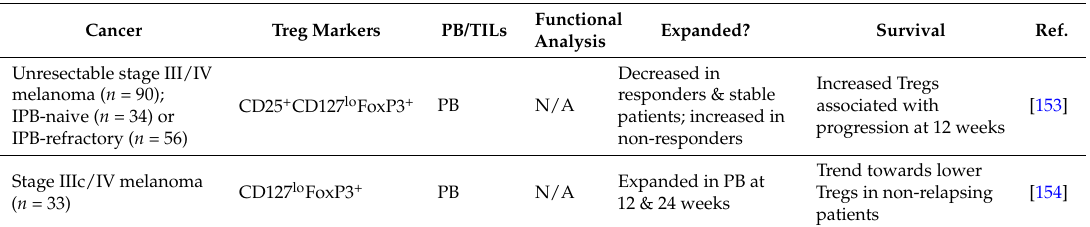
Table 4. Clinical studies investigating the impact of nivolumab on Tregs. Cancer Treg Markers PB/TILs